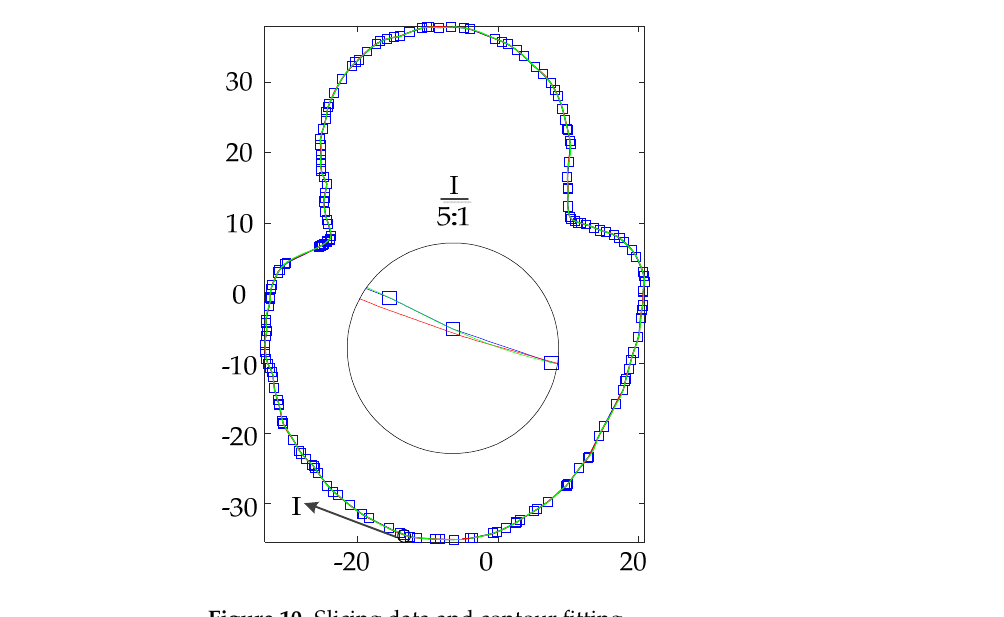
Figure 11. Approximation error of sliced data and fitted data.